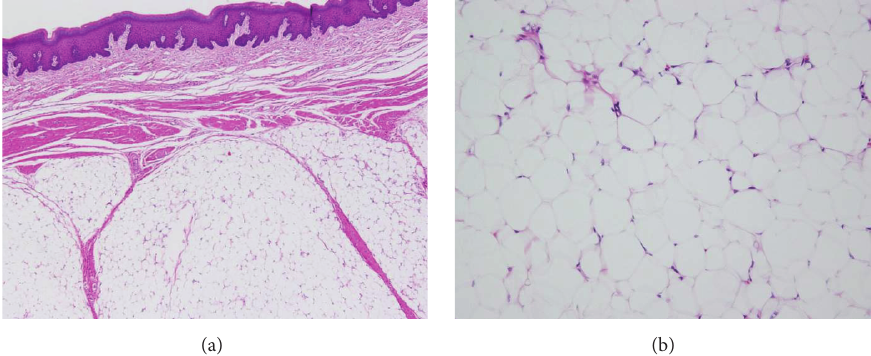
Figure 6: Histopathological image ((a) H-E × 100, (b) H-E × 200). The tumor consisted of proliferation of mature adipocytes.